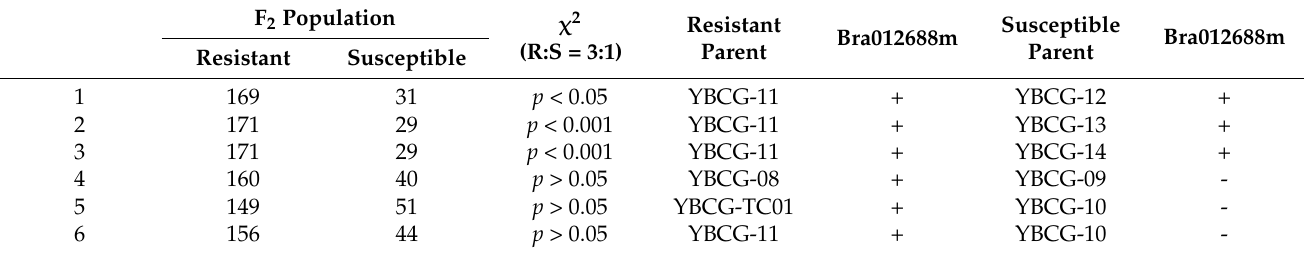
Table 2. Linkage analysis using six individual F 2 populations.